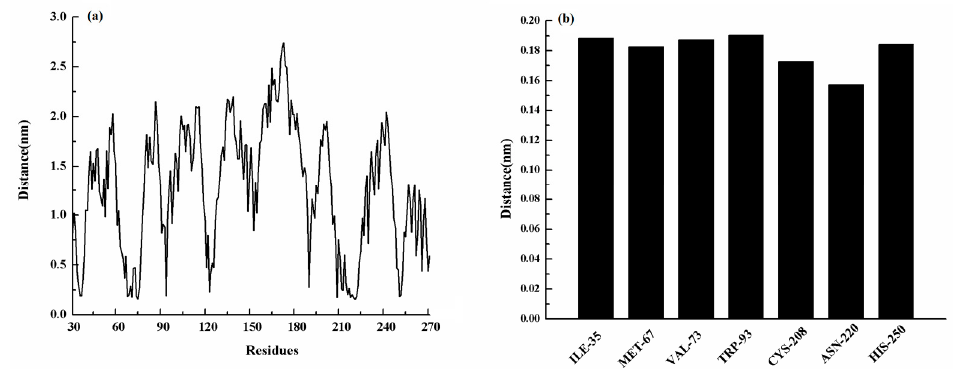
Figure 4. ( a ) The distance between the whole residues of NDM-1 and ZINC05683641; ( b ) the distances between residues of the binding sites of NDM-1 and ZINC05683641.